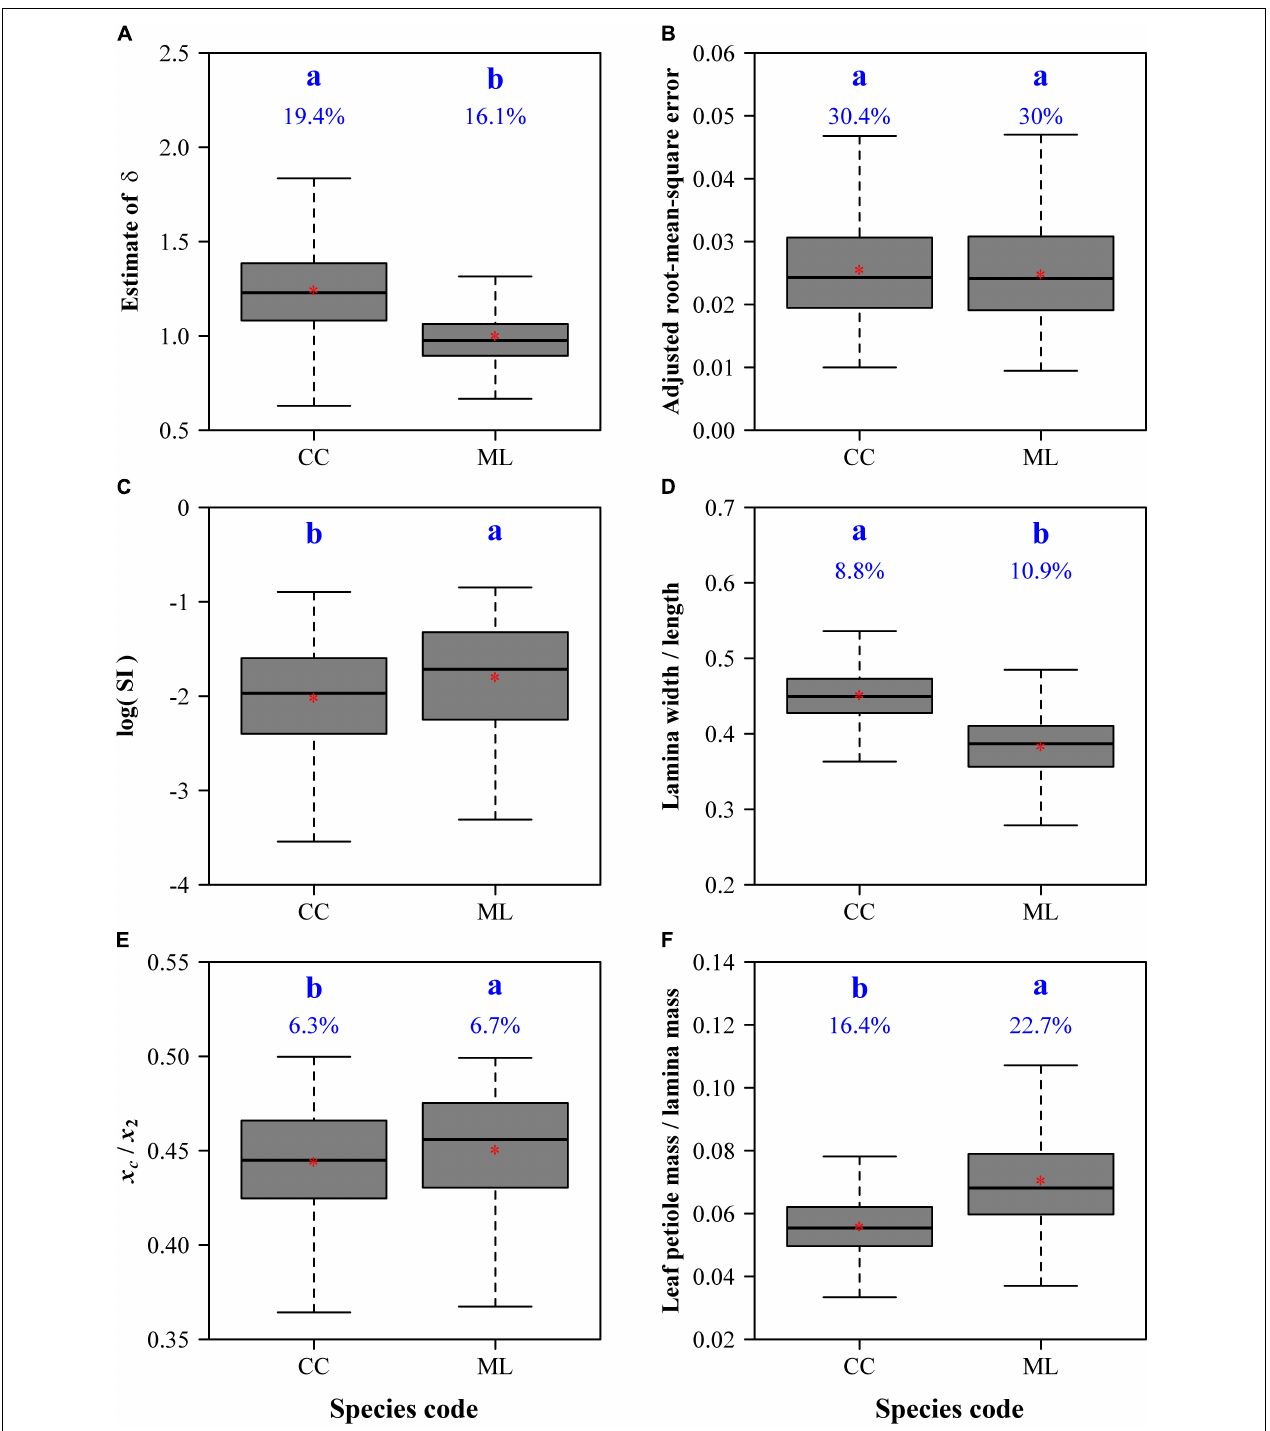
FIGURE 5 | Comparisons of the estimates of δ (A) , adjusted root-mean-square errors (B) , the natural logarithms of the standardized indices for lamina bilateral asymmetry (C) , ratios of lamina width to length (D) , centroid ratios (i.e., x c / x 2 ) (E) , and ratios of leaf petiole mass to lamina mass (F) between C. camphora (represented by CC) and M. leptophylla (represented by ML). In each panel, the letters a and b are used to represent the significance of the differences between the two species, with species sharing a common letter not differing significantly at the 0.05 significance level; the percentage numbers at the top of the whiskers represent the coefficients of variation; the horizontal lines in boxes represent medians, and the asterisks in boxes represent means.